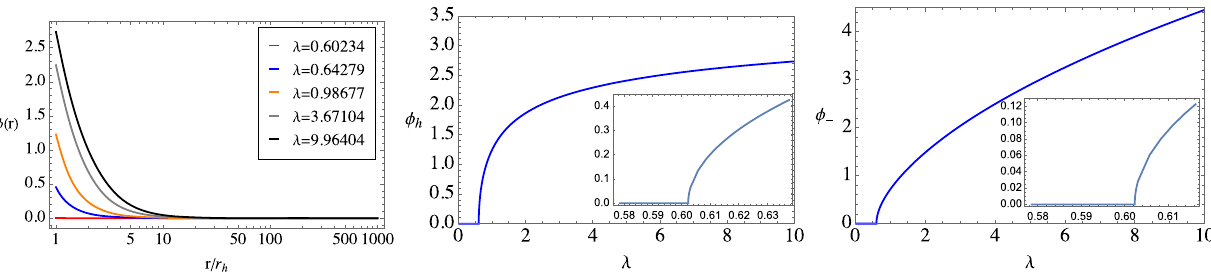
Fig. 2 Left: the profiles of the scalar field in asymptotical flat schwarzschild black hole with different values of λ . Middle: the value of scalar field near the event horizon φ h as the function of λ . Right: the corresponding scalar charge of the black hole φ − at infinity as the function of